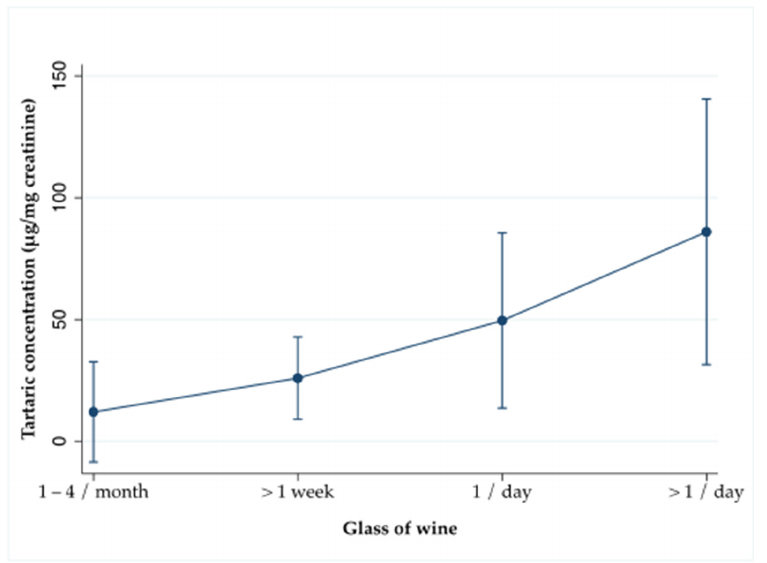
Figure 1. Relationship between urinary tartaric acid concentrations in urine and wine consumption expressed as glasses of wine.